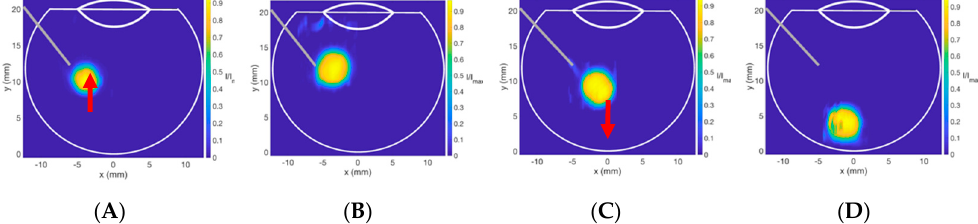
Figure 16. Contour plots of Coomassie blue dye injected into S500 and S1000. ( A , B ) Upward movement showing the buoyancy of injected bolus into S1000 (density: 1.09 g / mL) and ( C , D ) downward movement of the injected solution into S500 (density: 0.97 g / mL).